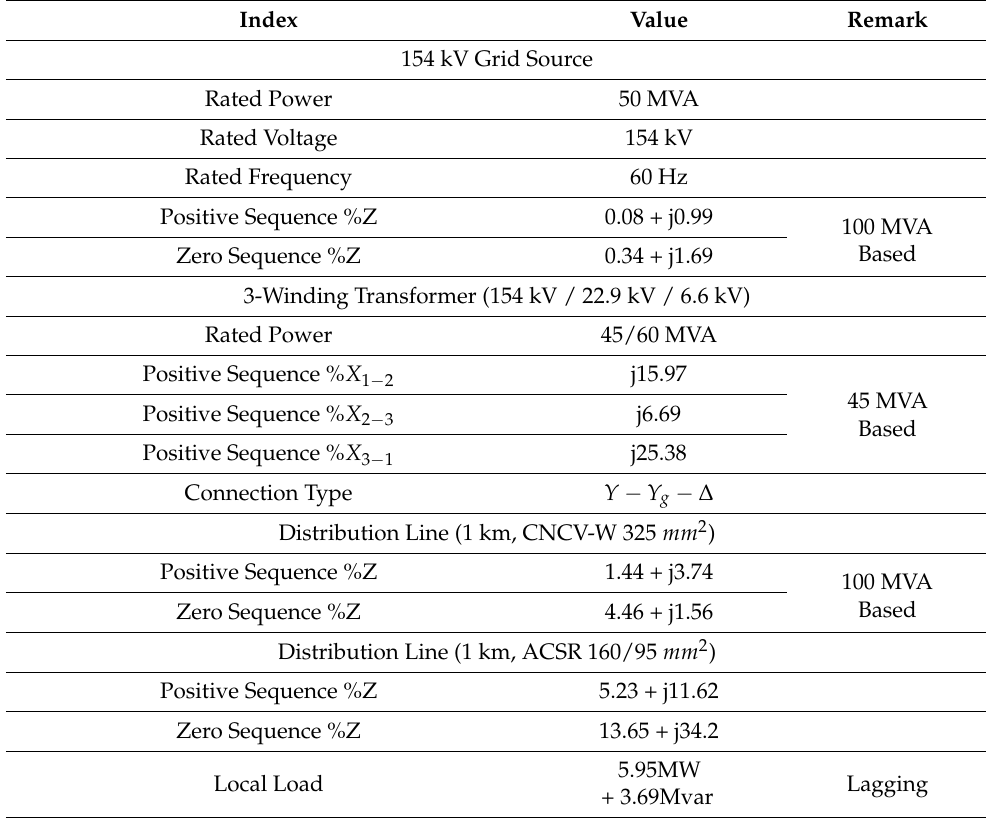
Figure 10. Modeling of the distribution system. Table 1. Specification of the distribution system.